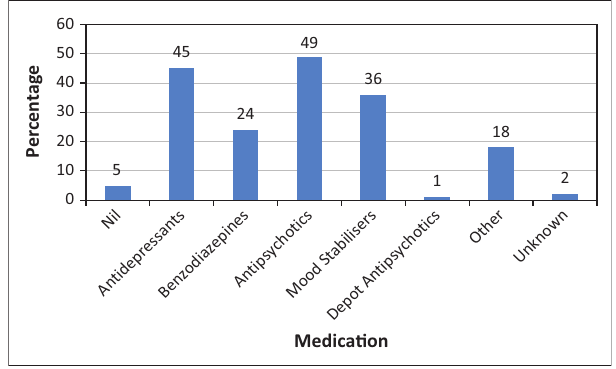
FIGURE 4: Type of medication on discharge of patients with borderline personality disorder admitted to the acute psychiatric unit at HJH during 2010.